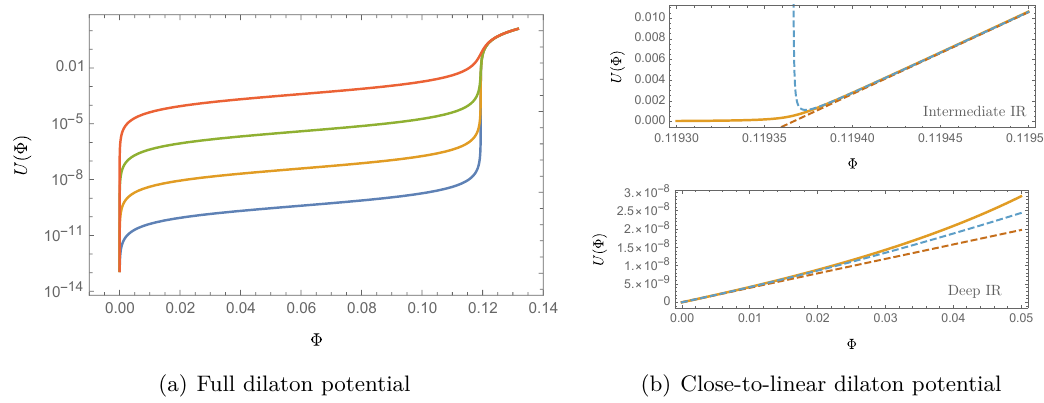
Figure 3 . (a) Dilaton potential for s = 10 − 5 , − 4 , − 3 , − 2 , from bottom to top. The almost vertical regimes in this logarithmic plot correspond to regimes of linear dilaton potential, that we zoom in (b). In a physical setting, the potential will be cut-off in the UV at a value of Φ where the potential is still linear, so the curvy features in the upper-right corner of the plot will not be of interest. (b) We zoom close to the linear regimes in the deep and intermediate IR regions for the yellow curve with s = 10 − 4 . The dashed lines correspond to the approximations given in (6.8) and (6.9). The brown line corresponds to keeping only the linear term, while in light blue we also included the first